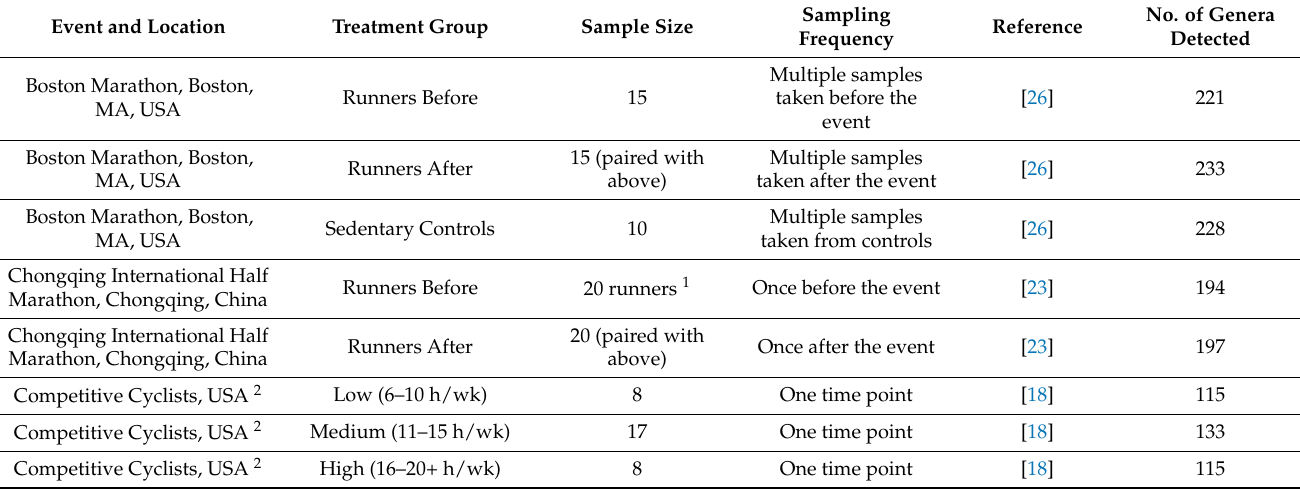
Table 1. Datasets used in this work and number of microbial genera detected in our bioinformat- ics